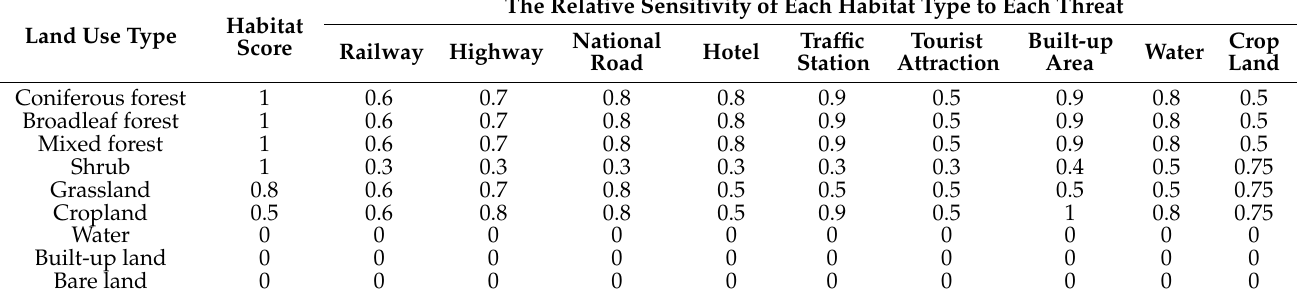
Table 3. Habitat scores and the responses to threat factors of land use types. Score Railway Highway